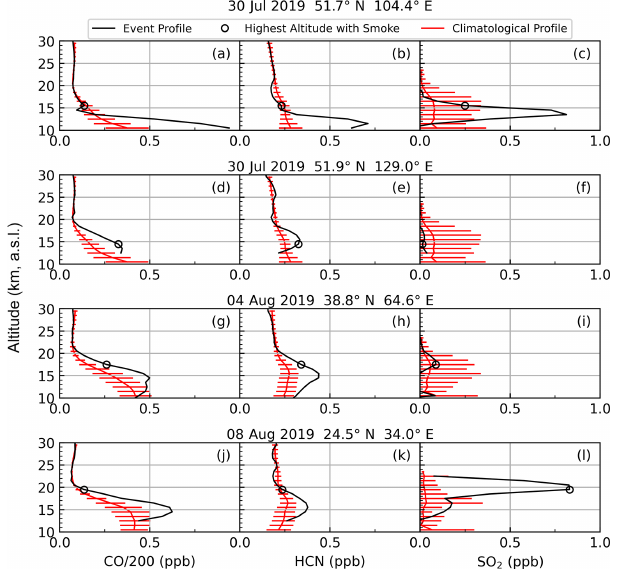
Figure 19. SAGE and ACE-FTS profiles collected in close prox- imity (both temporally and geographically). Colored dots in (a) in- dicate the SAGE-based composition classification. Panel (a) also shows the calculated spectral slope for this profile and the back- ground slope values ( ˜ X m ± MAD ∗ m ). Panel (b) presents the ACE- FTS CO